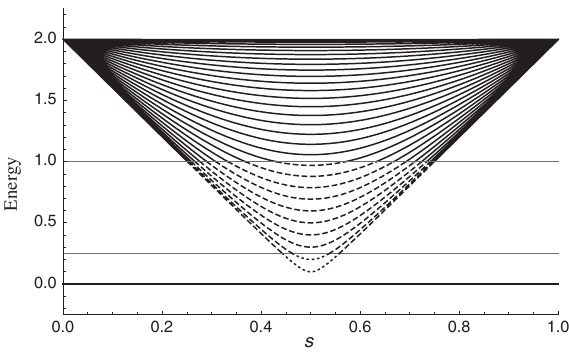
FIG. 7. When one exactly solves the one-dimensional wire, the result is that the wire behaves like a collection of free fermions. Here, we show the energies for creating each of these fermions in a chain of length 80 (thus, all the energy levels are sums of these energies) as a function of the scaled time s . See Eq. (A22) in Appendix A. For high-energy excitations, if the environment is cool enough, then these energy levels are essentially never excited (solid lines.) At energies comparable to the temperature of the environment, errors will no longer be suppressed by a Boltzmann factor (dashed lines). At the lowest energies, the interaction strength between the environment and the system is small enough that the error model will not be governed by detailed balance. However, assuming that these energy levels are changed by any process whatsoever is no worse than our assumption that all errors below the temperature cutoff lead to real errors.